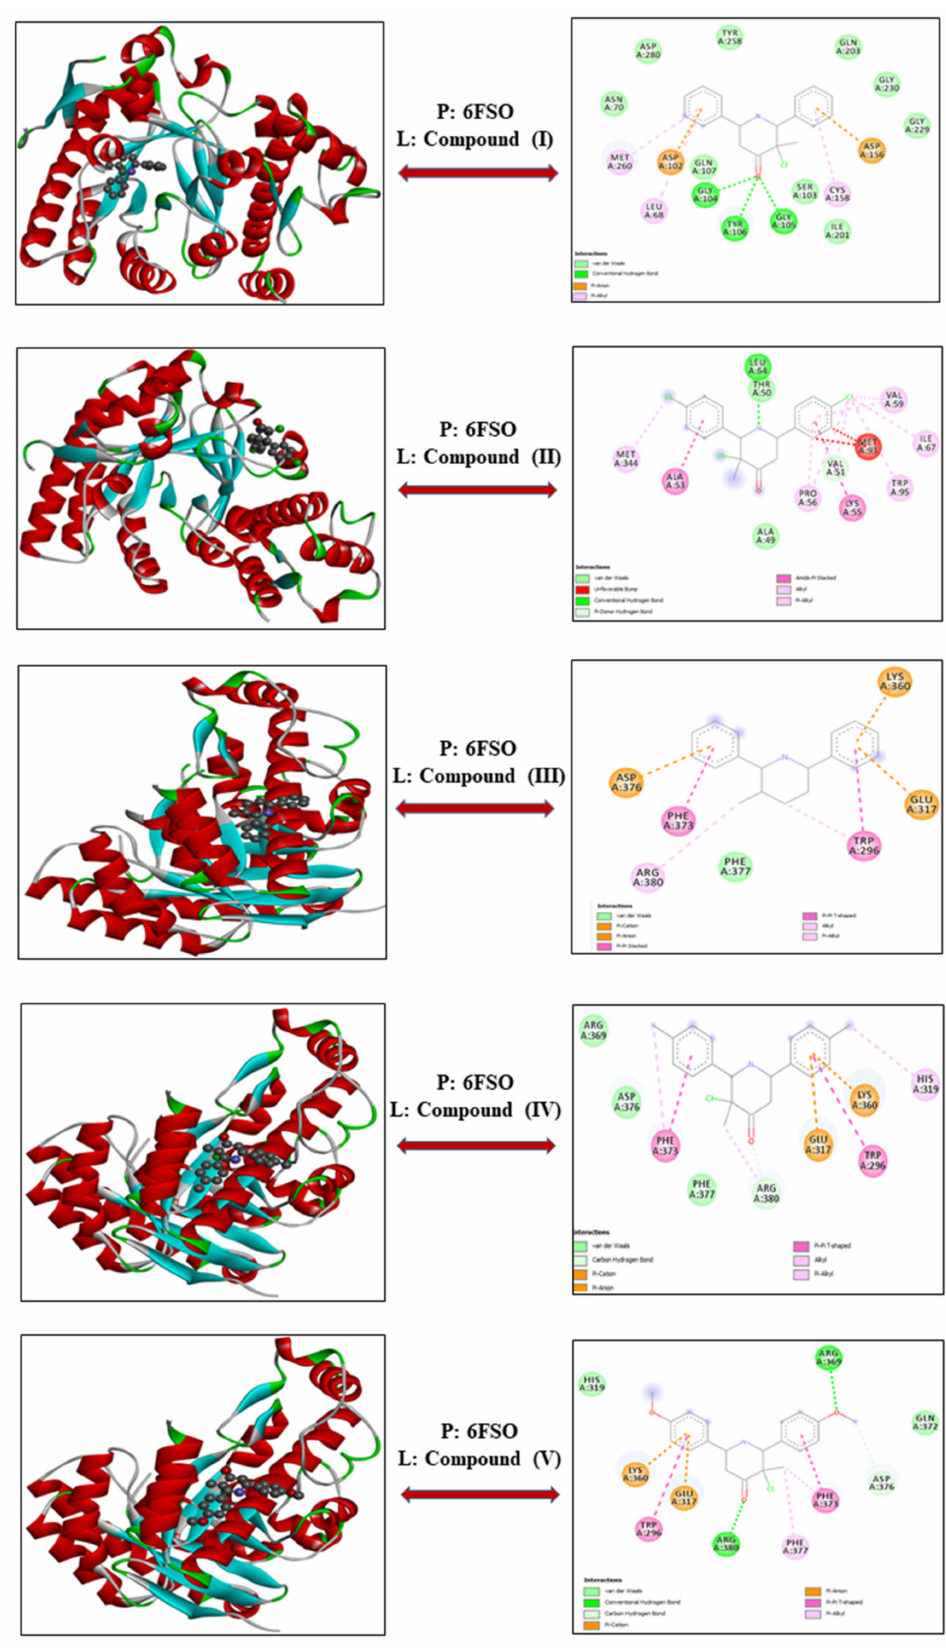
Figure 2. Compounds I – V (ligands) and 6FSO (protein) are all best-docked positions, and the right side shows the lowest-energy 2D